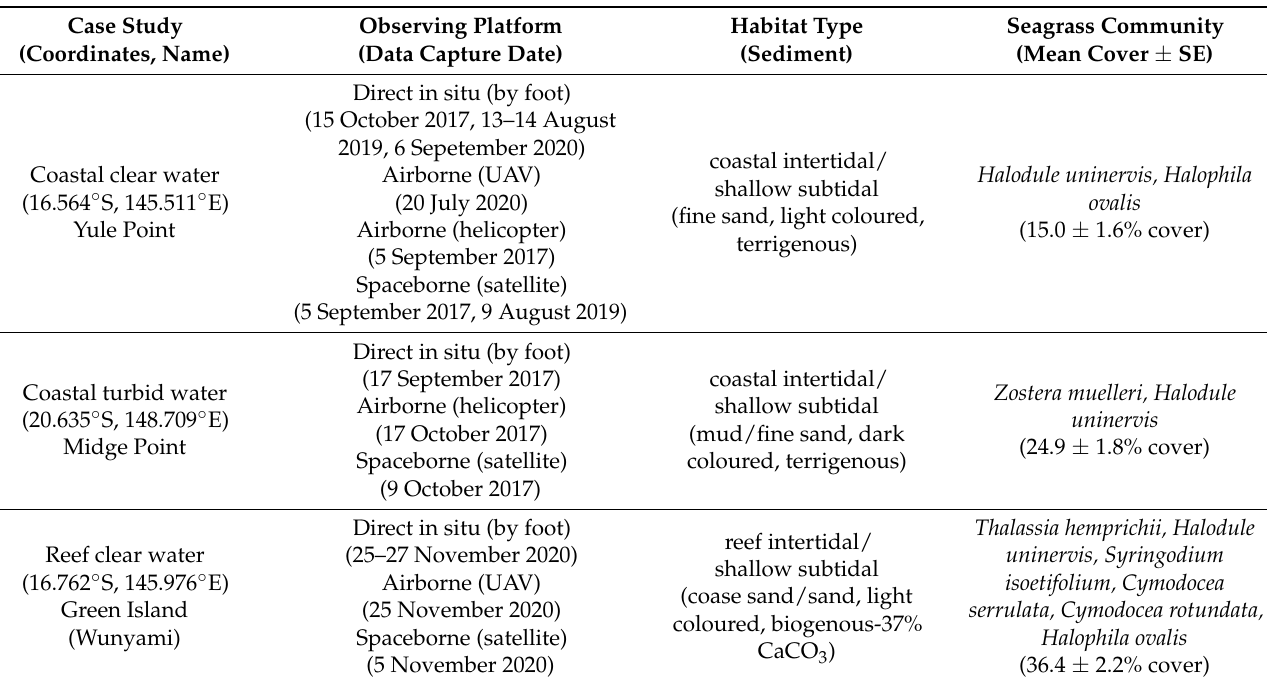
platform, habitat (including description of sediment grain size, colour and origin), and seagrass community (incl. long-term percent cover from 2000 to